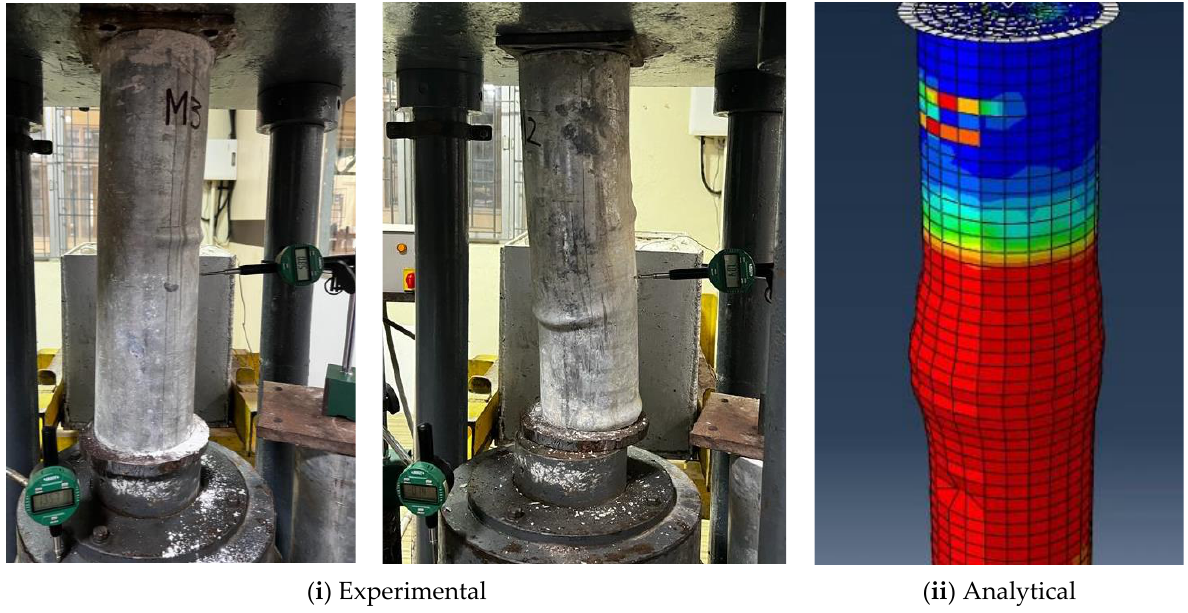
Figure 14. Failure modes of PVA fiber-reinforced self-stressed concrete columns.